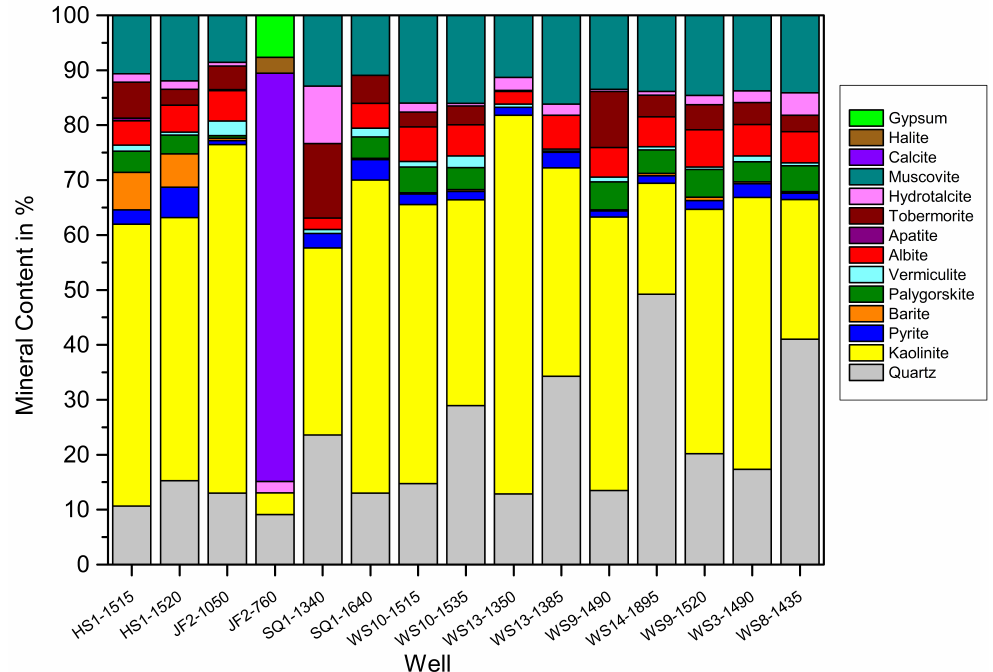
Figure 5. Mineralogy distribution (XRD